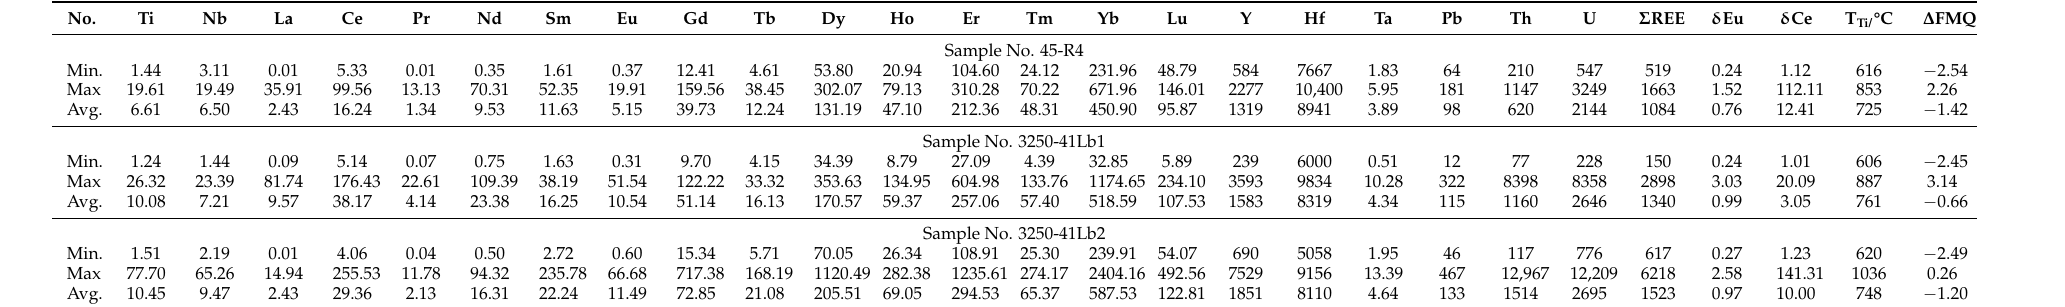
Table 1. LA-ICP-MS analytical results of zircon trace elements (ppm), Ti-in-zircon temperatures (T Ti /°C), and oxygen fugacity parameters ( ∆ FMQ) in the Yangla quartz